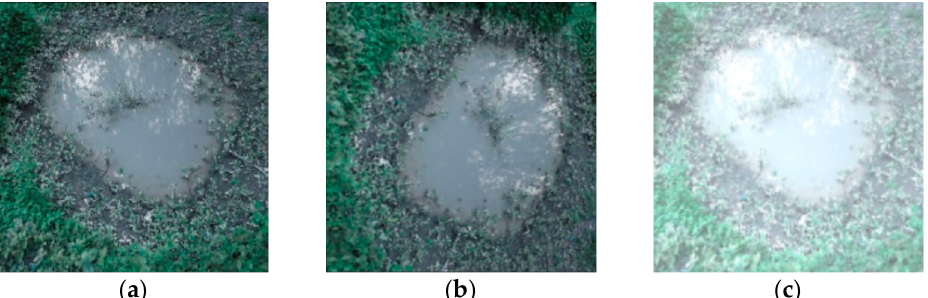
Figure 7. Applying data augmentation techniques to increase the negative samples to balance the sinkhole dataset while training the segmentation models. ( a ) The original image; ( b ) random rotation; and ( c ) adjusted brightness. The figure shows a small puddle drawn from the negative samples.